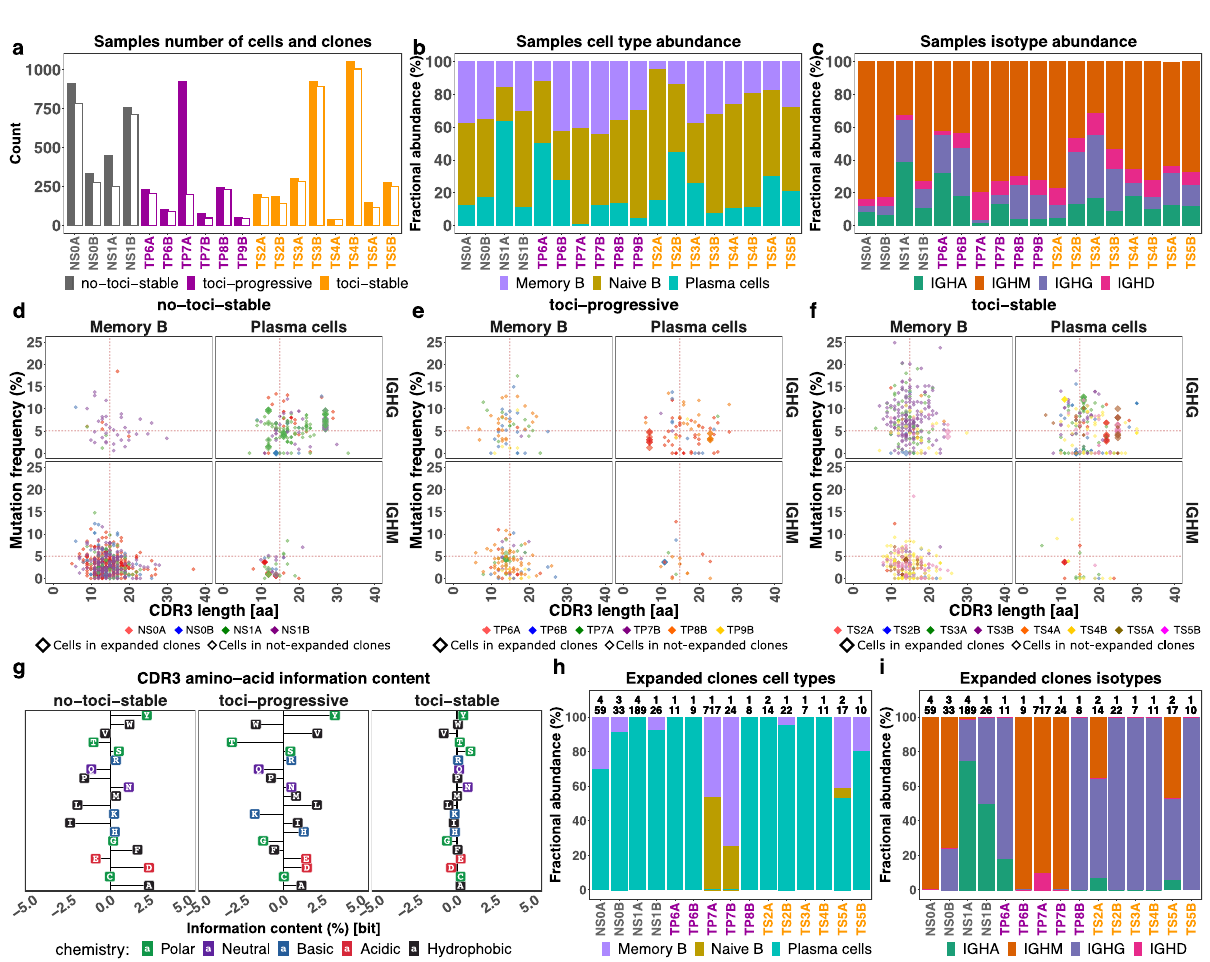
Fig. 8 BCR data analysis, part 1. a Number of cells (closed-bars) and number of clones (open-bars) in patients colored based on the treatment and status of the disease. b Fractional abundance of memory B cells, naive B cells, and plasma cells in each sample. c Fractional abundance of isotypes (IGHM/D/G/ A) in each sample. d – f CDR3 amino acid length ( x axis) and mutation frequency ( y axis) for each cell type (memory B cell and plasma cell columns) and isotype (IGHG and IGHM rows) of stable patients with no treatment, progressive patients under treatment, and stable patients under treatment. Colors indicate different samples. Vertical dashed line represents 15 amino acid CDR3 length reference point and horizontal line represents 5% mutation frequency reference point. Points with larger size belong to the expanded clones. g CDR3 amino acid usage at time-point B relative to A for patients grouped based on the treatment and status of the disease. h Cell type fractional abundance of expanded clones in each sample. Labels in each bar represent the number of expanded clones (top) and number of cells (bottom). i Isotype fractional abundance of expanded clones in each sample. Labels as described in h . Source data are provided as a Source Data fi